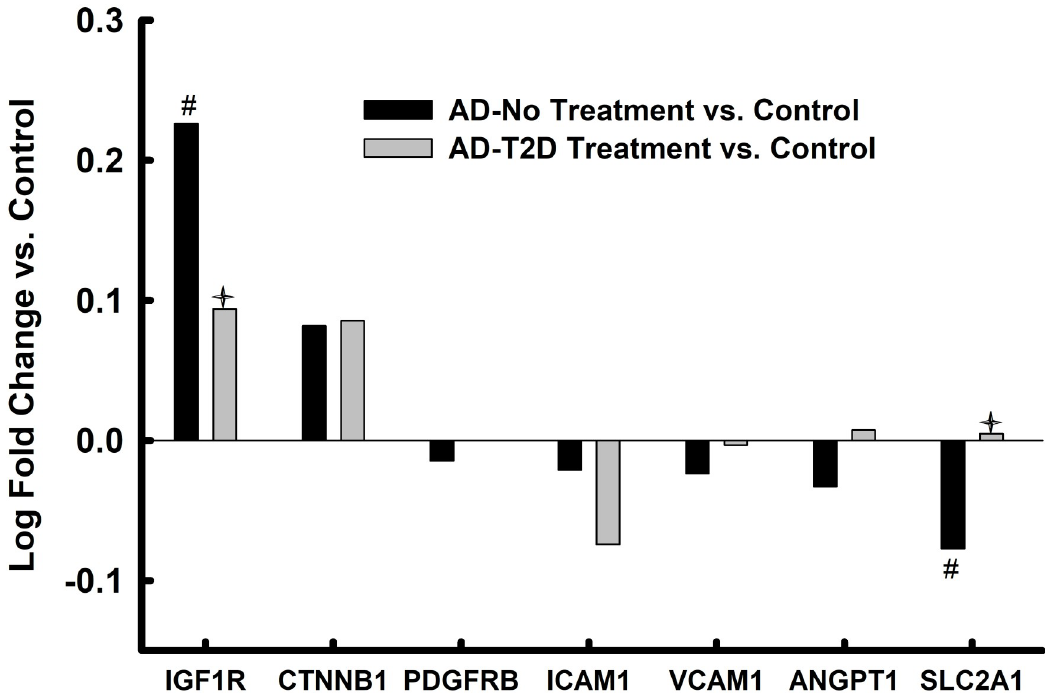
Fig 2. Endothelial cell markers in parahippocampal gyrus bulk tissue. Values represent relative log fold change in persons with AD relative to controls and log fold change in persons with AD and T2D who had been treated with anti-diabetes agents. � = p < 0.05 after FDR correction; # = p < 0.05 without FDR correction; ✦ = p < 0.05 AD-No Treatment vs. AD-T2D